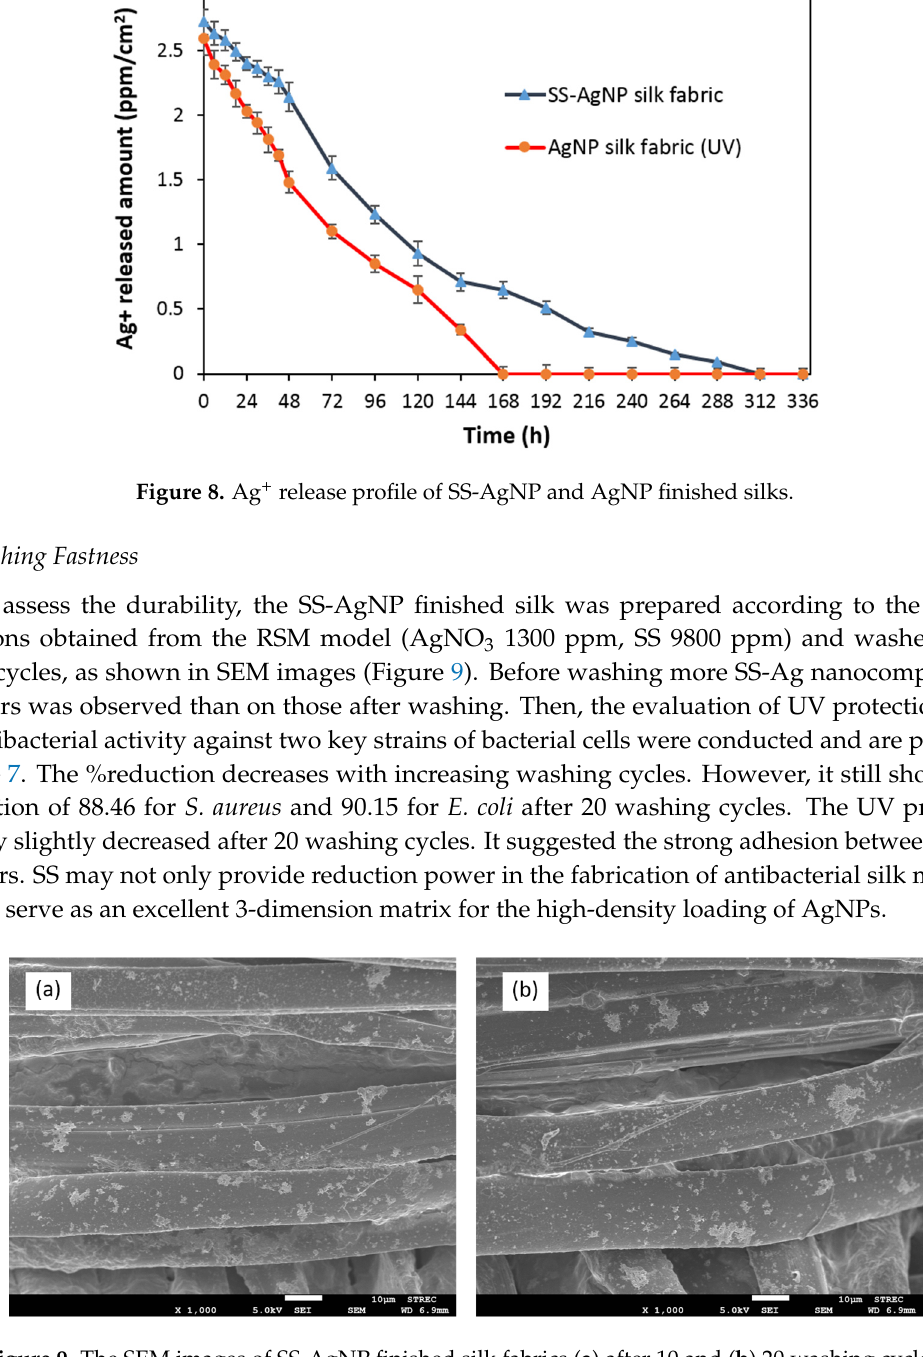
Figure 9. The SEM images of SS ‐ AgNP finished silk fabrics ( a ) after 10 and ( b ) 20 washing cycles. Table 7. Properties of UV protection and antibacterial activity of SS-AgNP samples after